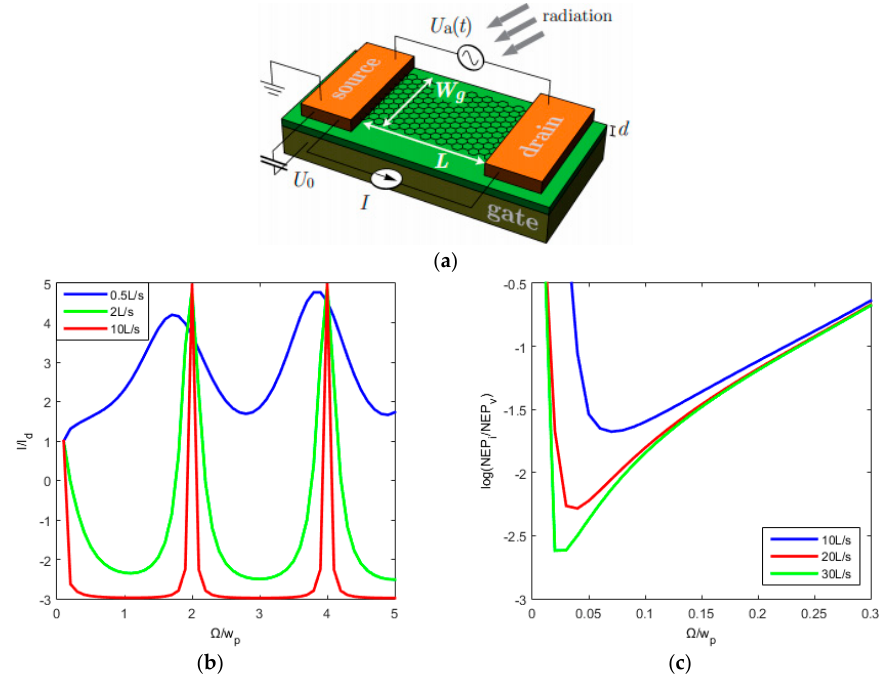
Figure 7. ( a ) The layout of a GFET utilising the Dyakonov Shur Instability (reproduced from [51] with ( a ) The layout of a GFET utilising the Dyakonov Shur Instability (reproduced